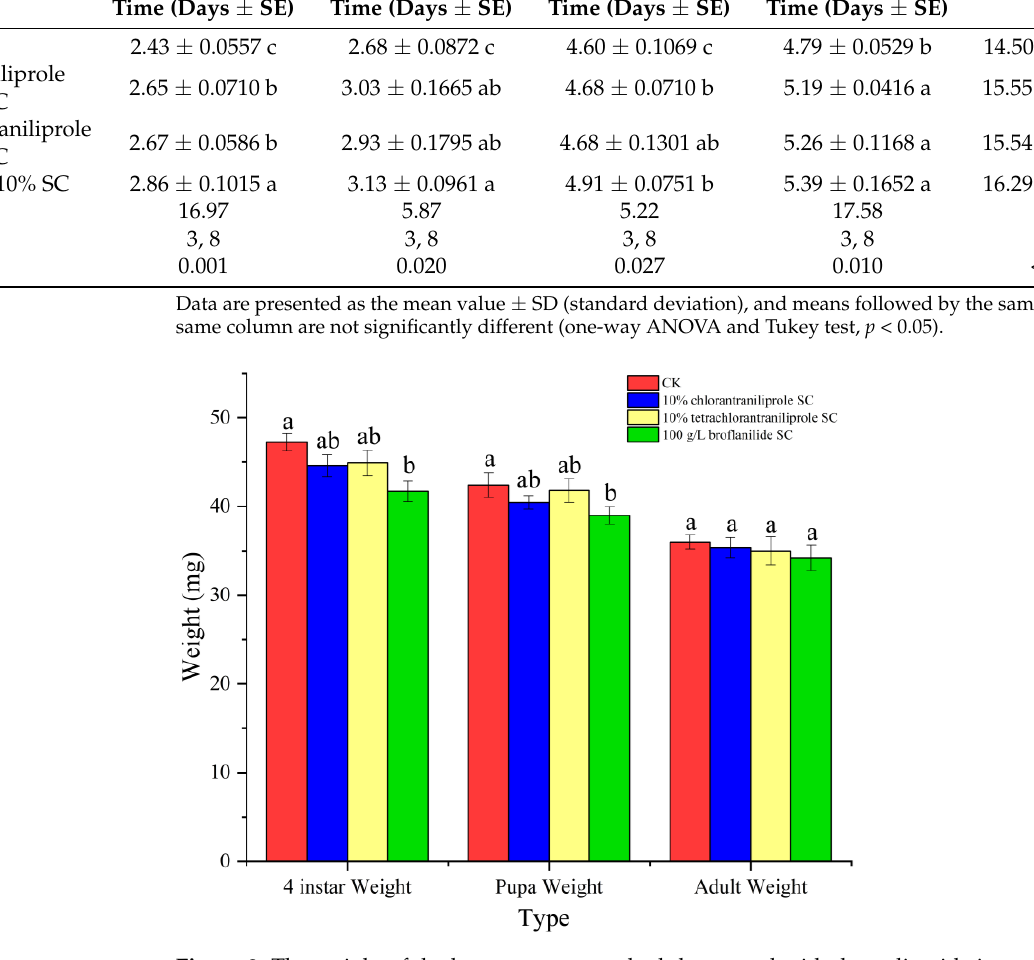
Figure 2. The weight of the larvae, pupae, and adults treated with three diamide insecticides (mean value relative to ‘individual’ weight in each test system and error bars). Data from the same period are marked with different lowercase letters and are significantly different (ANOVA, HSD test, p < 0.05).